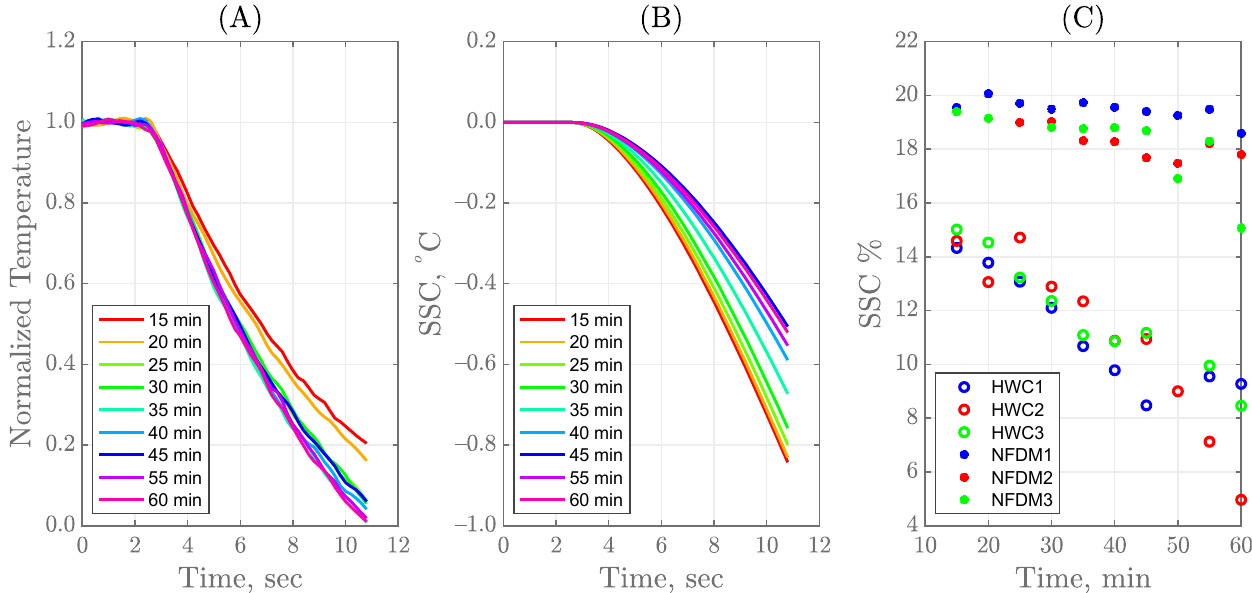
Figure 4. ( A ) Normalized temperature of all experiments for one HWC trial, ( B ) Scaled sensitivity coefficient (SSC) for estimation of the thermal conductivity of HWC at 140 °C, and ( C ) percentage of the change in temperature represented by the SSC at each data point for HWC and NFDM.